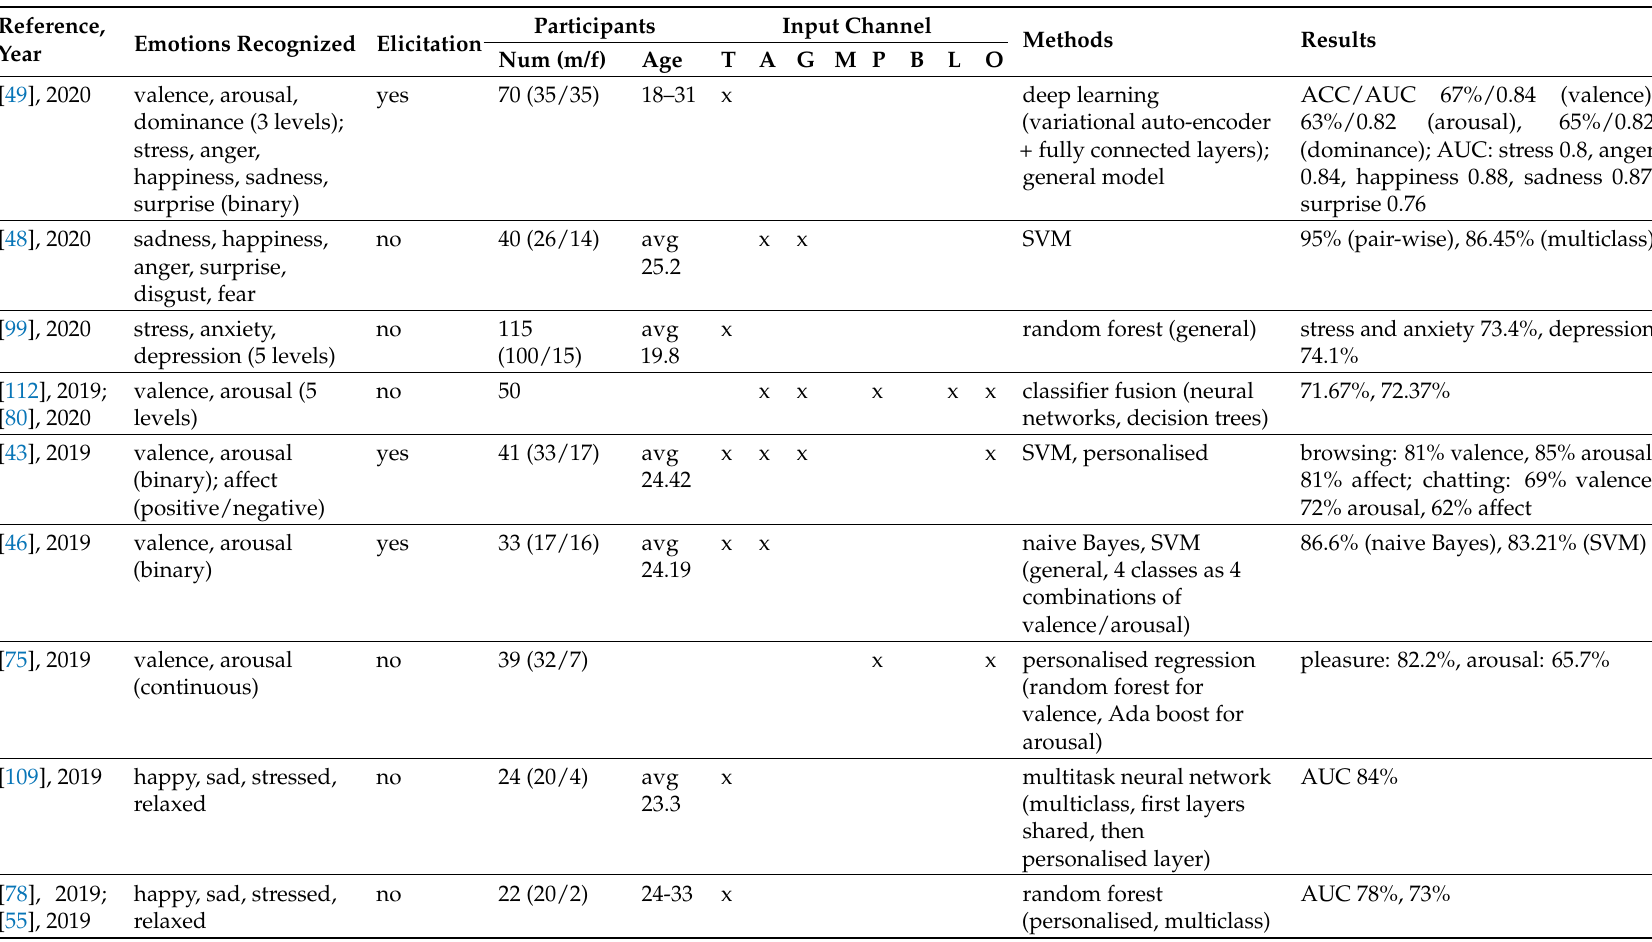
Table 2. Studies on smartphone emotion recognition. m/f—males/females, T—touchscreen, A—accelerometer, G—gyroscope, M—magnetometer, P—GPS, B—bluetooth, L—light, O—other